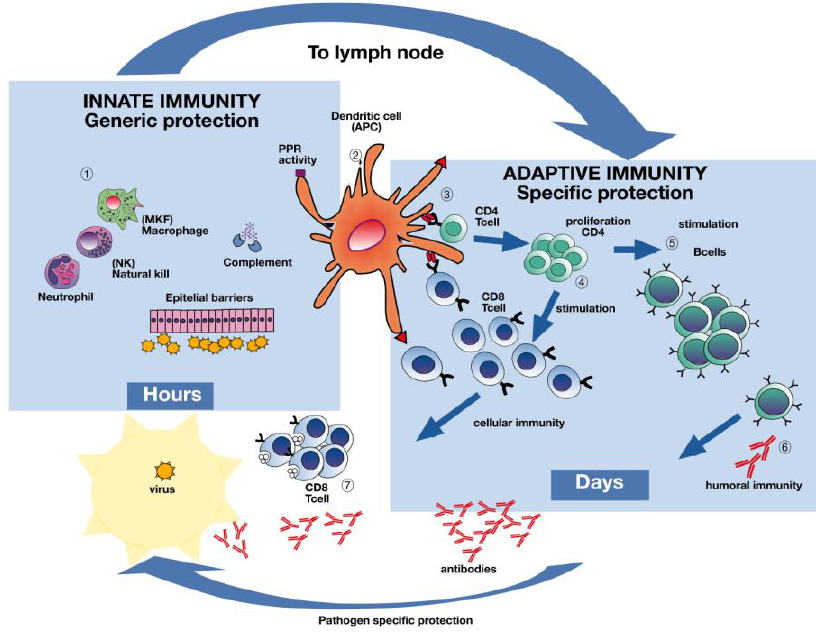
Figure 2. The immune response to influenza infection. Influenza virus infection elicits a multifaceted immune response. Live attenuated influenza vaccines activate both humoral and cellular immune responses while inactivated influenza vaccines predominantly elicit antibodies. Deeper understanding of the natural protective immune responses after influenza infection will aid in designing future influenza vaccines capable of activating both humoral and cellular immune responses covering several or possibly all influenza strains. Dendritic cells in the airway mucosa present influenza proteins both through the major histocompatibility complex classes I and II to CD4 and CD8 T-cells (Section 3). Antigen presenting cells (APCs) (Section 2) recognize the virus and the subsequent activation of pro-inflammatory cytokines occurs, inducing viral resistance in uninfected neighboring cells, as well as recruiting other immune cells (Section 1). The adaptive immune system will produce virus specific antibodies, as well as CD4 and CD8 T-cells, which are capable of destroying virus infected cells (Sections 4, 6, 7). Although slower, the adaptive immune system has memory and the capacity to recognize an unlimited number of antigens with great specificity, as opposed to the generic response of the innate immune system. Figure made in collaboration with GC Johnsen at the University of Bergen, Norway .